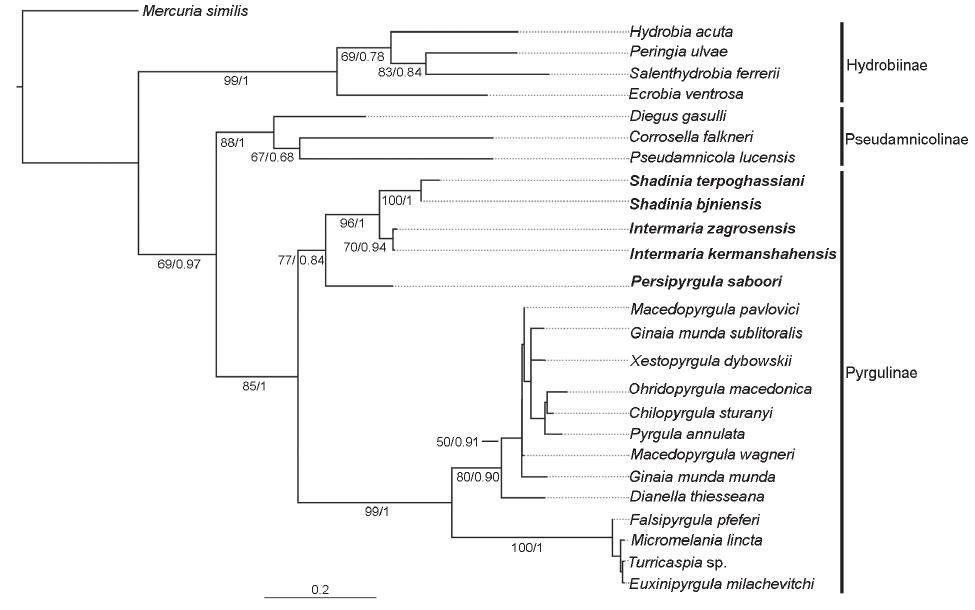
Fig. 1. Bayesian inference of hydrobiid species based on COI sequences. Values below branches indicate bootstrap supports for maximum likelihood and BPPs for Bayesian inference. Black bars on the right denote subfamily assignments. Scale bar: expected change per